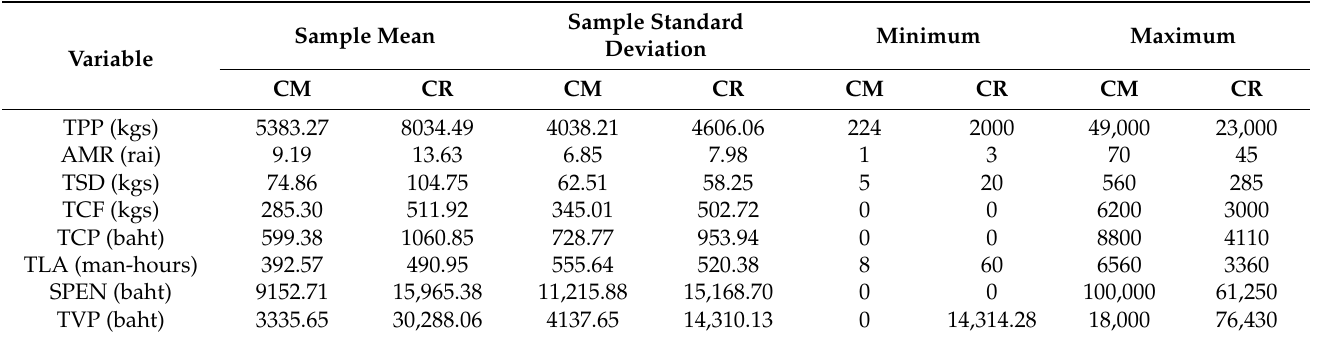
Table 1. Summary statistics of key variables for major rice farmers in Chiang Mai and Chiang Rai